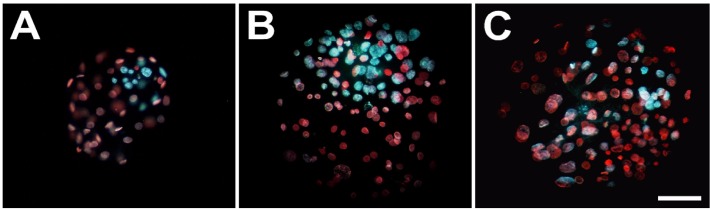
Representative images of differentially-stained porcine day 6 blastocysts.A singleton (A) and 3X aggregate blastocyst with compact (B) or scattered or non-compact (C) inner cell mass (ICM). Using a conventional differential staining method, ICM were labeled with Hoechst 33342 (blue) and trophectoderm (TE) nuclei with propidium iodide (red); photographed under an epifluorescent microscope. Scale bars: 100 μm.